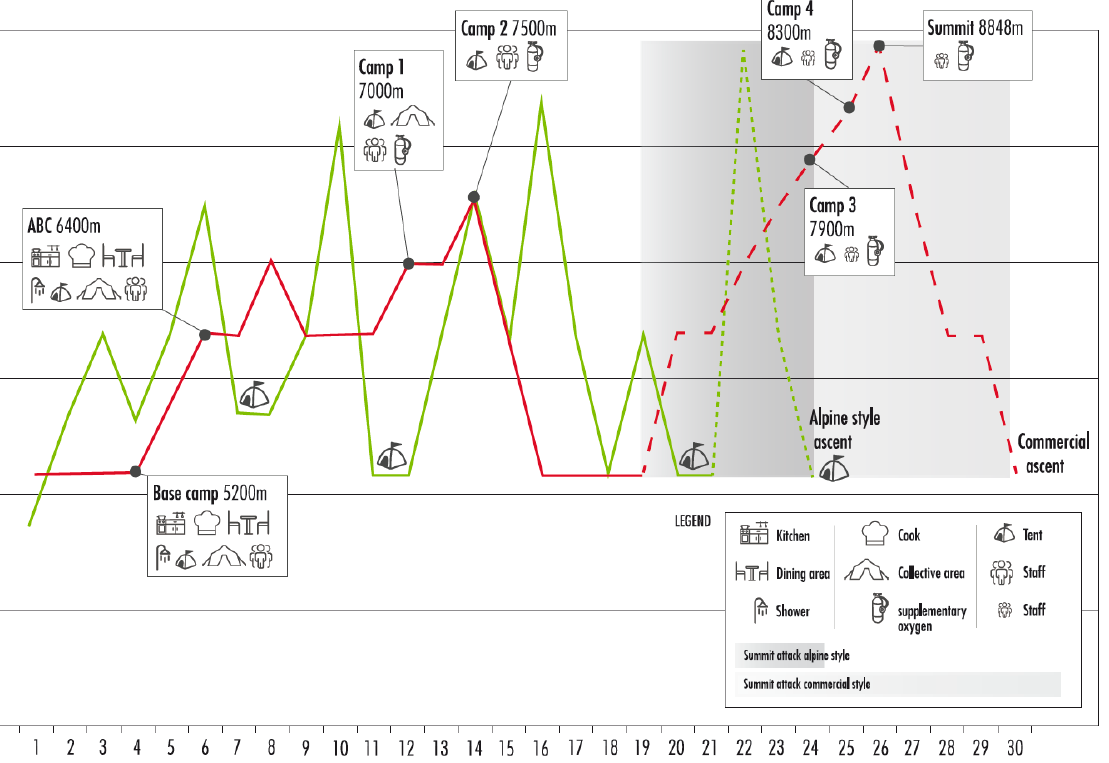
Figure 1. The typical acclimatisation and ascent profiles of commercial and alpine-style ascents to Mt. Everest (North face).